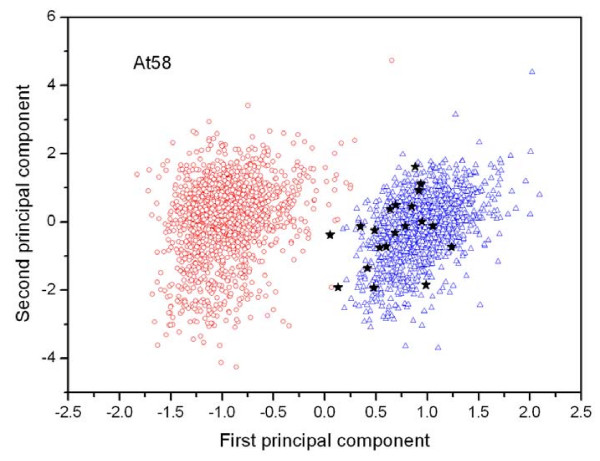
The distribution of points on the principal plane spanned by the first (x) and second (y) principal axes using the principal component analysis (PCA) in At58. The red circles represent the function-known genes, the blue triangles represent the corresponding negative samples and the black stars denote the recognized non-coding ORFs. The first and second principal axes account for 33.96% and 14.98% of the total inertia of the 21-dimensional space, respectively. It is clear that most of the identified non-coding ORFs distribute far from the core of open circles, and close to the core of open triangles, which implies that the recognized non-coding ORFs are very unlikely to encode proteins.